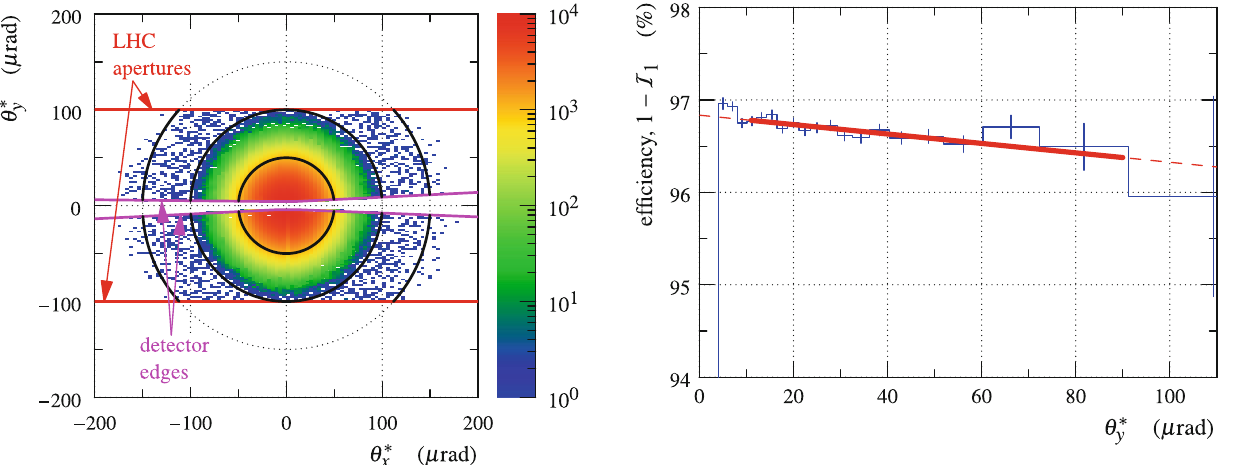
Fig. 7 Distribution of scattering angle projections θ ∗ y vs. θ ∗ x , data from LHC fill 5317. The upper (lower) part comes from the diagonal 45 bottom–56 top (45 top–56 bottom). The red horizontal lines represent cuts due to the LHC apertures, the magenta lines cuts due to the RP edges. The dotted circles show contours of constant scattering angle θ ∗ = 50,100 and150 μ rad.Thepartsofthecontourswithinacceptance are emphasized in thick black